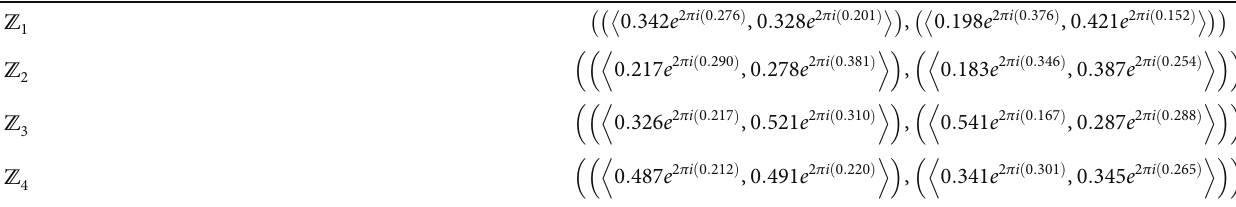
Table 5: The aggregated value of Av S :